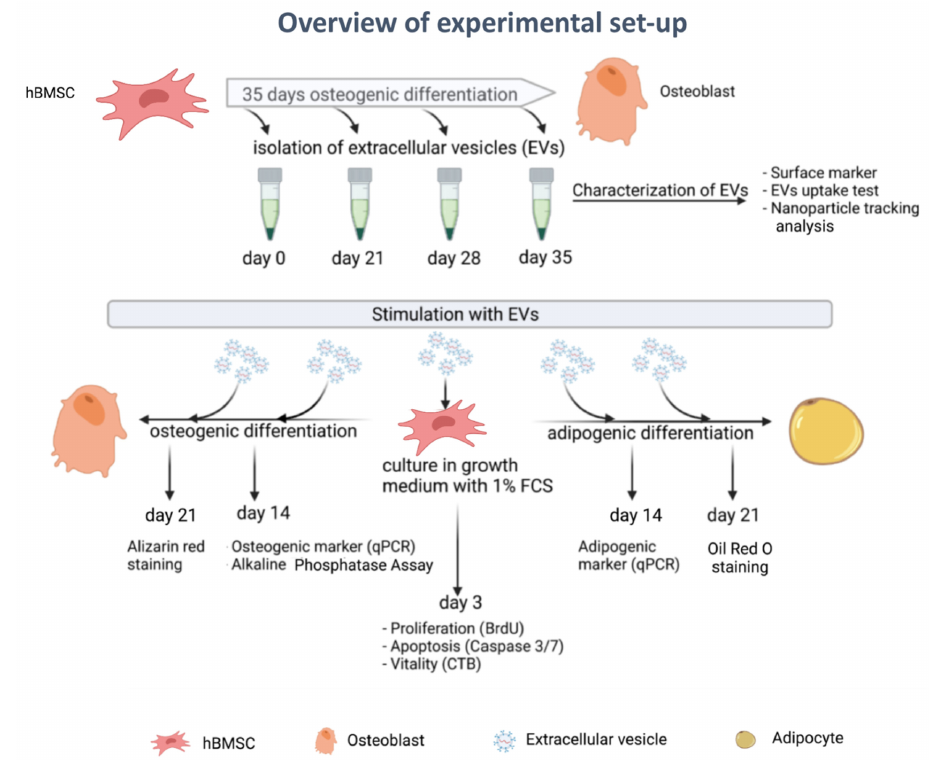
Figure 1. Overview of experimental set-up; EVs = extracellular vesicles.